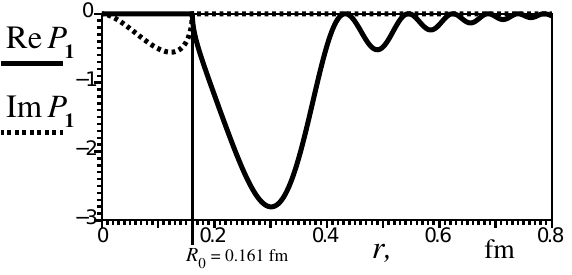
Figure 9. Real (solid) and imaginary (dotted) parts of the pressure P 1 ( r ) versus r .